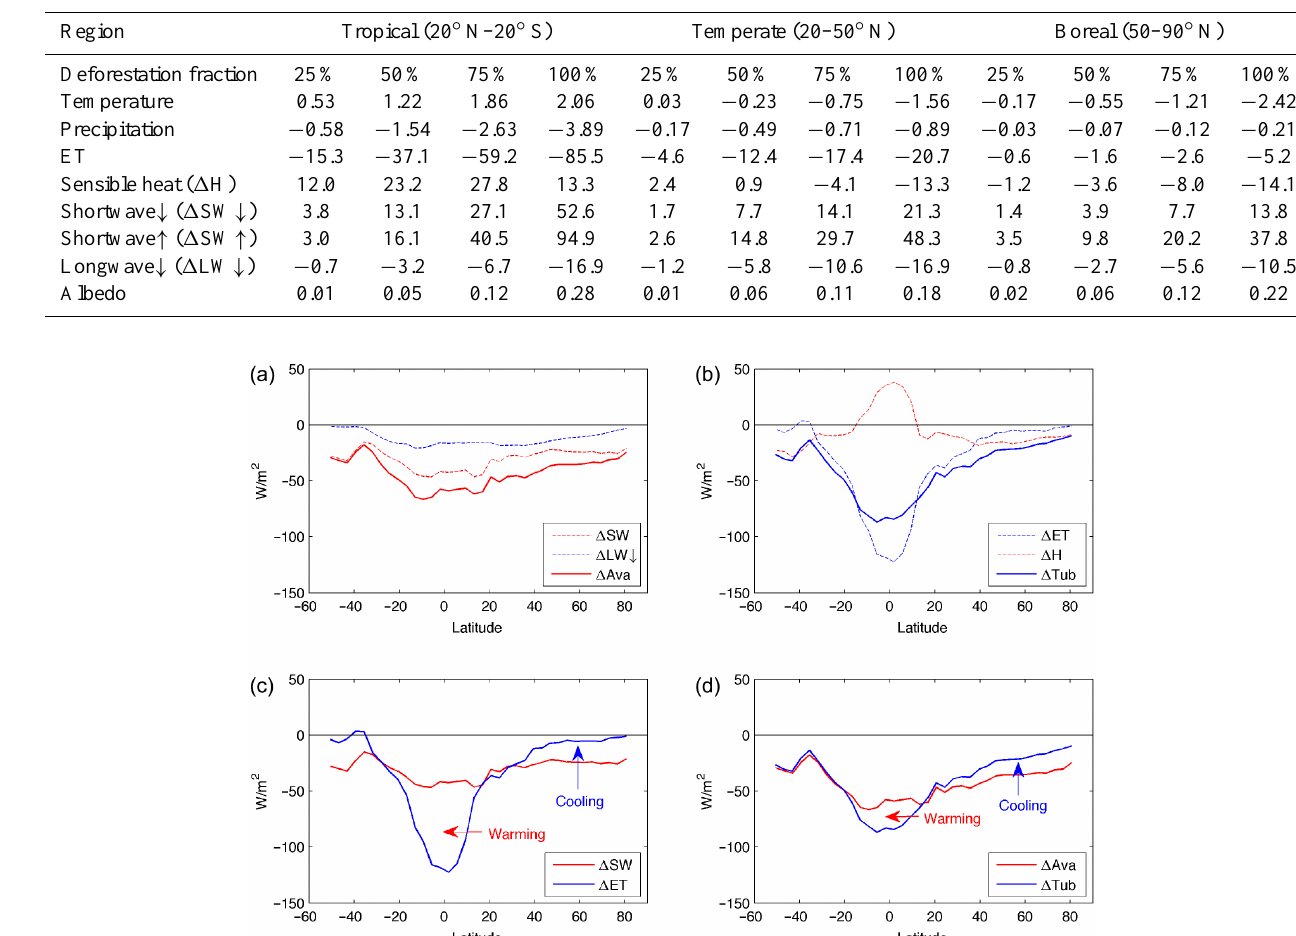
Table 3. Changes in key climate variables from global deforestation with different deforestation fractions. “ (cid:49) ” denotes change relative to the control experiment. The value for each climate variable is the area-weighted change over deforested areas for different latitude zones. The symbol “ ↑ ” denotes upward and “ ↓ ” denotes downward. Units are watts per square meter for energy flux, kelvin for temperature, millimeters per day for precipitation; albedo is unitless.